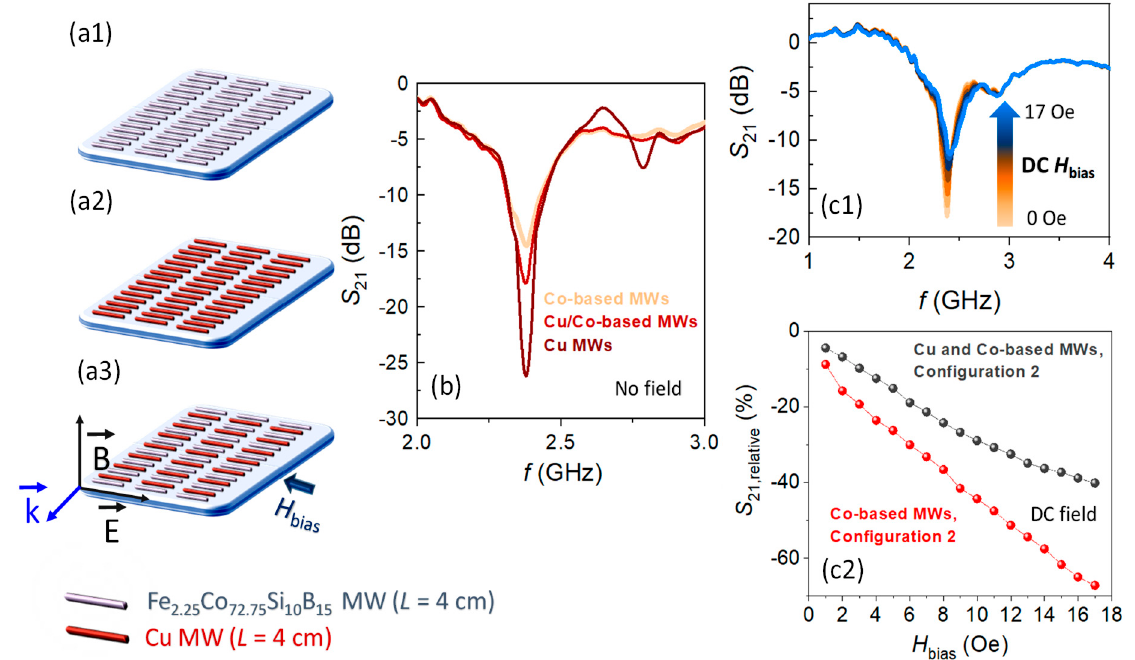
Figure 8. Influence of non-field and DC magnetic field conditions on the microwave scattering for the configuration 2: schematic illustration for sensing array platforms composed by ( a1 ) Co-based MWs, ( a2 ) Cu MWs, and ( a3 ) a combination of Co-based and Cu intercalated MWs; ( b ) the S 21 transmission coefficient obtained for the three cases under non-field conditions; ( c1 ) the S 21 transmission coefficient obtained under a DC magnetic field between 0 and 17 Oe for the combination of Cu and Co-based MWs arrays (combination ( a3 )), and ( c2 ) S 21,relative value calculated for the combined system of Co-based and Cu MWs. The S 21, relative distribution of the combination ( a1 ) with Co-based MWs is also added for comparison.